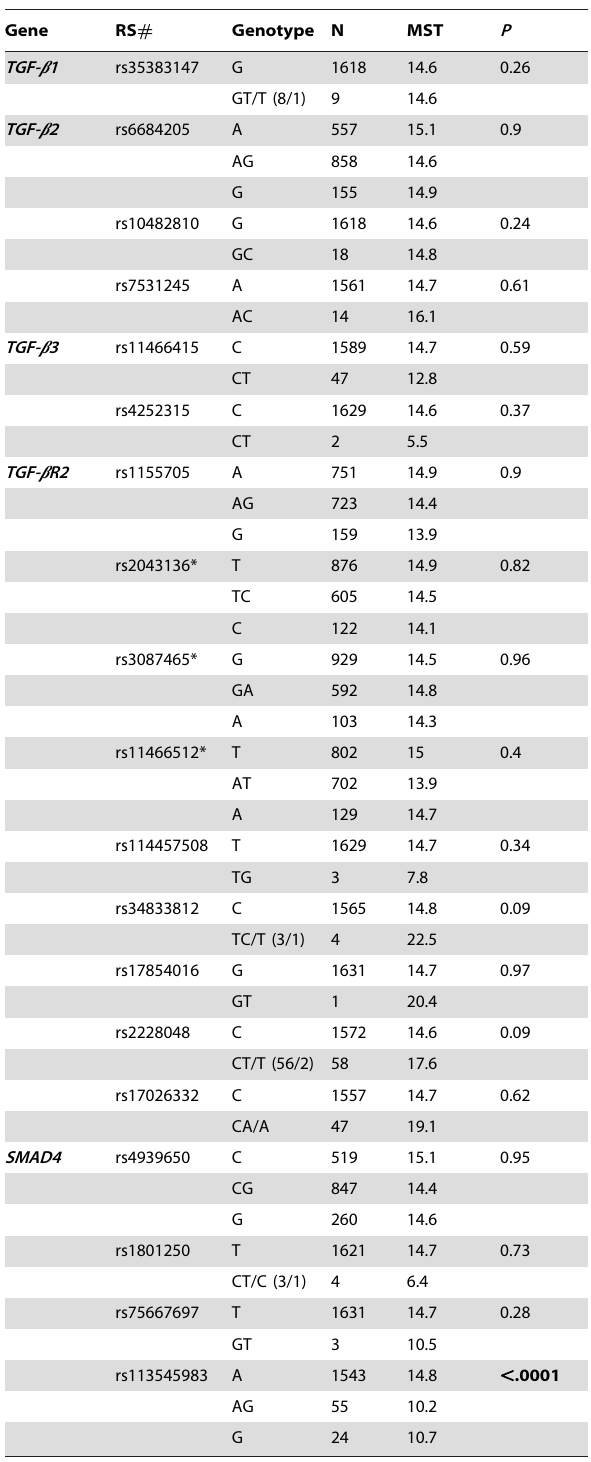
Table 4. MAF and functional significance of the SNPs investigated in the current study.